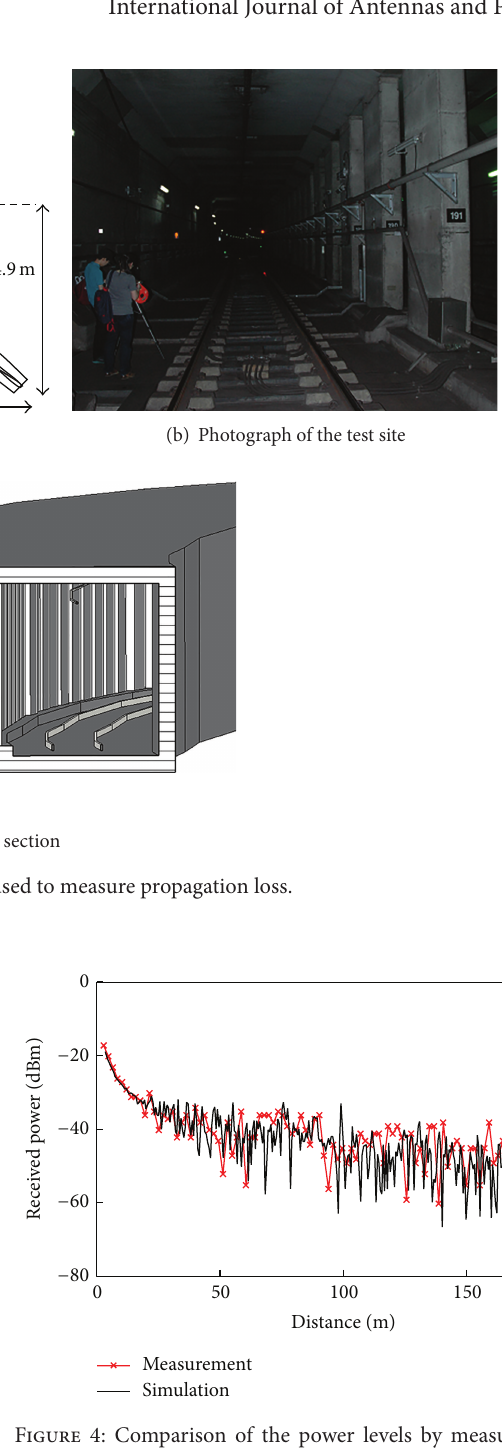
Figure 4: Comparison of the power levels by measurement and simulation shows good